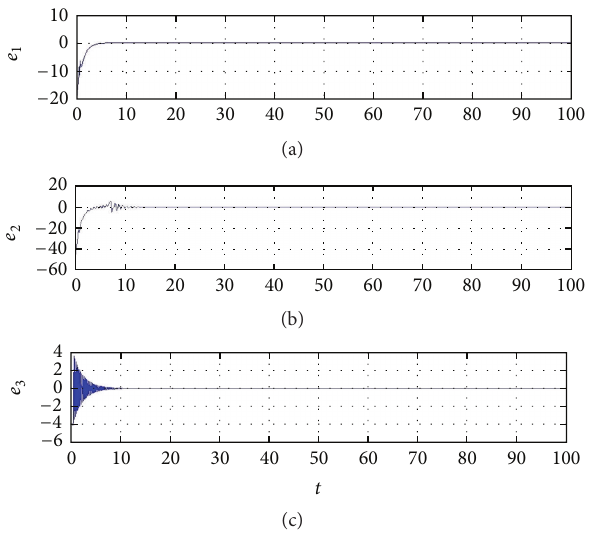
Figure 8: Time histories of errors for master and slave chaotic Lorentz systems.